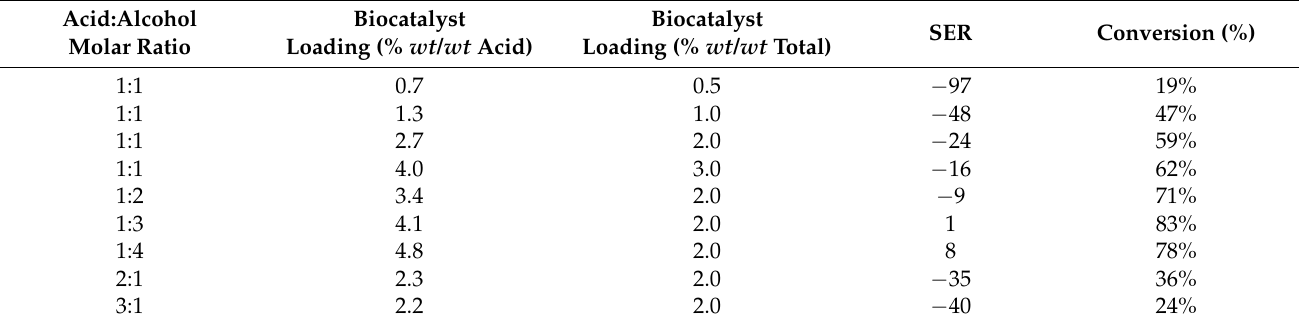
Table 3. SER and conversions results of the reaction conditions studied by Parikh et al. (2019) in the synthesis of propyl decanoate mediated by Fermase at 60 ◦ C, in the solvent-free system, 300 rpm, and 10 h. The biocatalyst loading is showed based both on wt / wt of the total mass of reagents and based on wt / wt of acid. Acid:Alcohol Molar